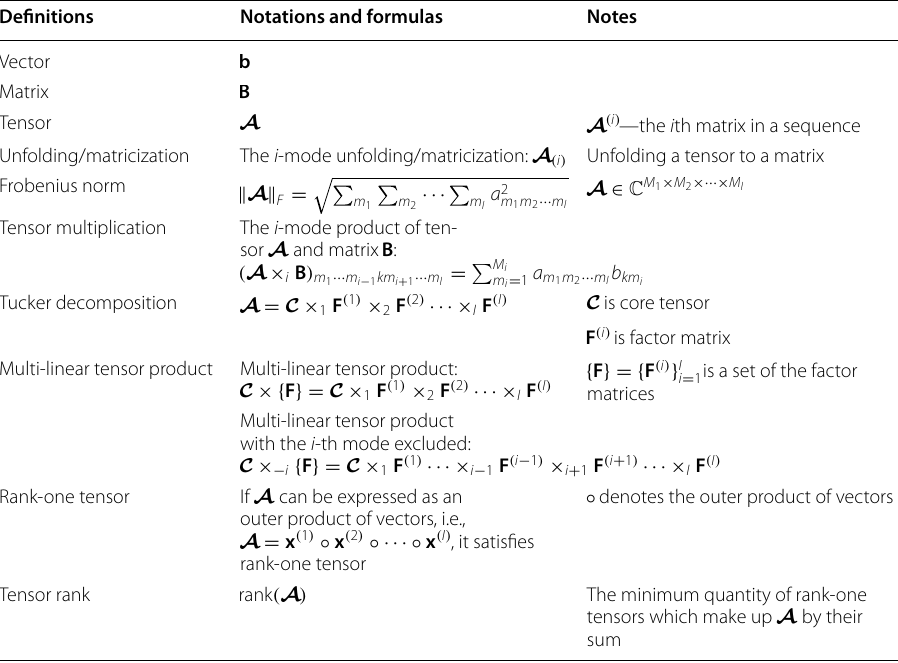
Table 1 Notations and